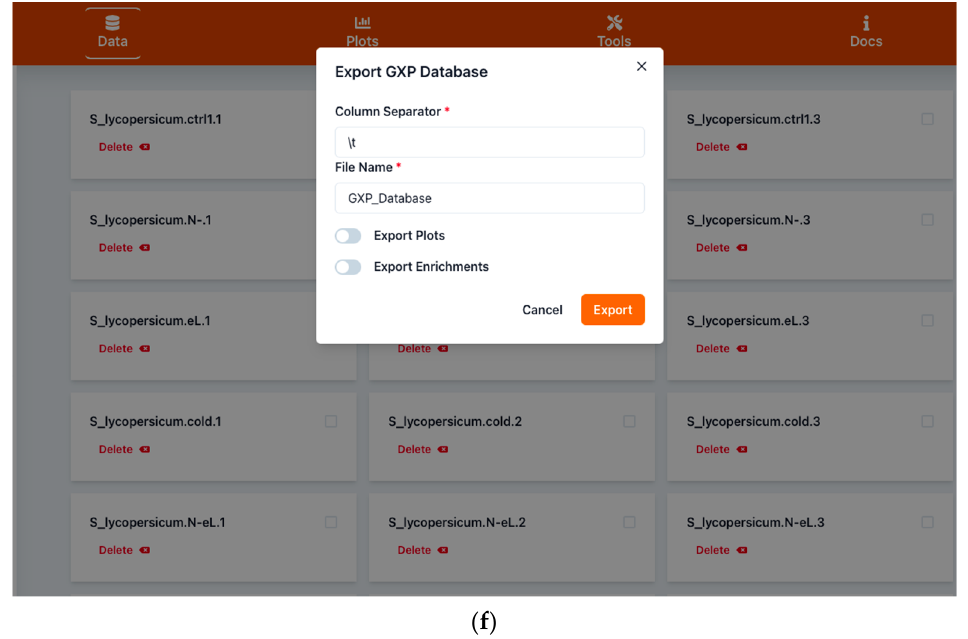
Figure 1. Screenshot images of Gene Expression Plotter (GXP) showing interfaces for data input. ( a ) shows the quantitative data table file import form, triggered by the first document button in the upper left panel. This form is used to load a quantification table such as the one shown in ( b ). ( c ) shows the transcript information table file import form, triggered by the second document icon in the left panel. This form is used to load an optional information table (see Section 1) like the one shown in ( d ). After successful import, the user can search for genes or their annotations in the “gene browser” (helix icon on the lower left panel). In the shown example, the user searched for “chalcone synthase”, a polyketide synthase involved in flavonoid biosynthesis. In ( e ) the user now inspects this gene’s expression quantifications (highlighted foreground) and additional information such as the logarithmic fold changes of gene expression assessed for various comparisons of control and stress treatments (lightly faded out background). Furthermore, as shown in ( f ), by using the GXP export function triggered by the fifth, upward arrow on the box icon in the left panel, GXP enables the user to save the current state, i.e., all imported data, generated plots, and analysis results for later continuation or to share it with other researchers.